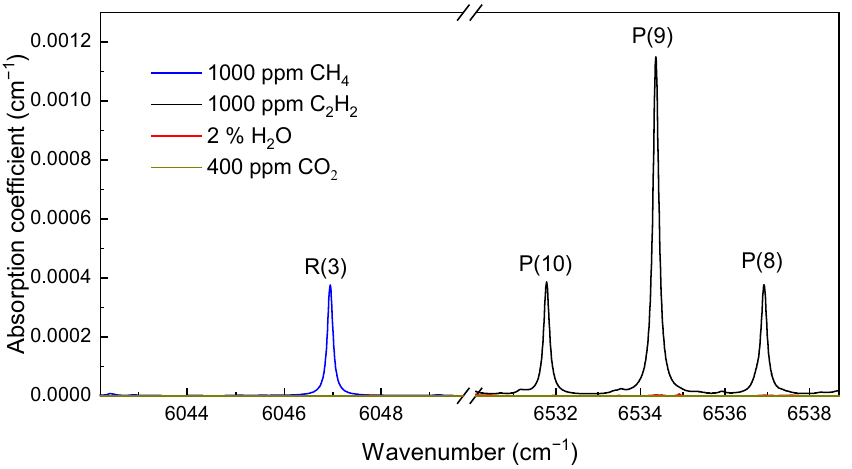
Figure 2. Absorption coefficient simulation for a gas mixture of 1000 ppm CH 4 , 1000 ppm C 2 H 2 , 2% H 2 O and 400 ppm CO 2 at 296 K and 1 atm.